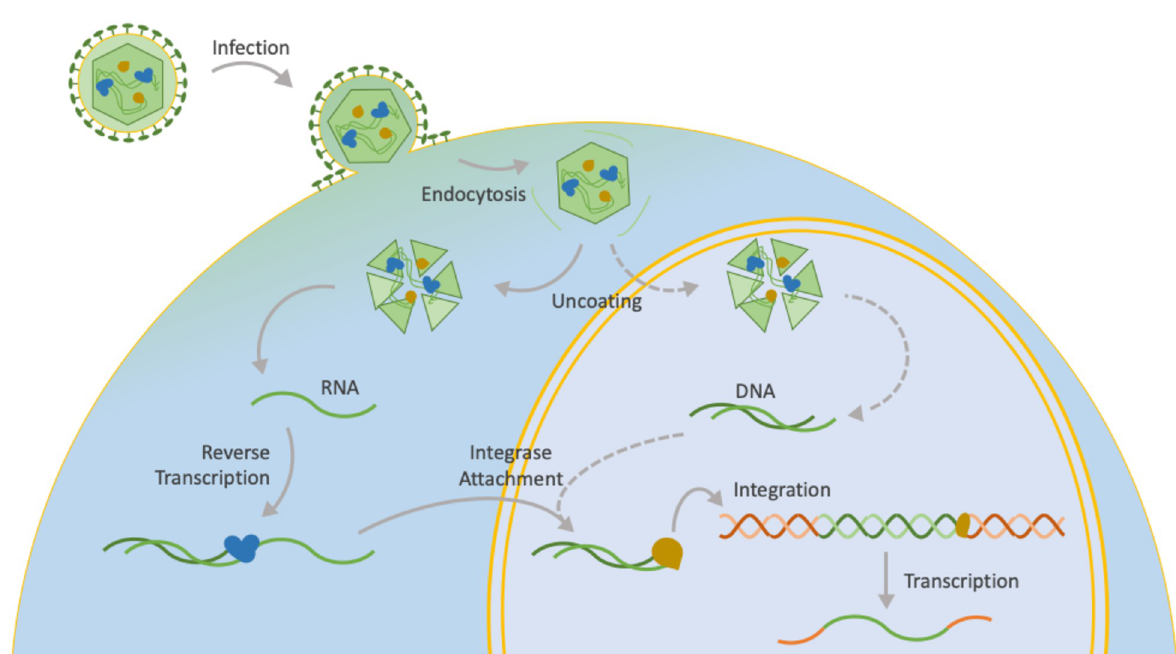
Fig 1. Biological schematic of virus integration. DNA viruses are indicated in dashed arrows, while RNA retroviruses and processes common to both are indicated in solid arrows. Inspiration for our hand-drawn figure is linked here (www.britannica.com/science/reverse-transcriptase) [13].